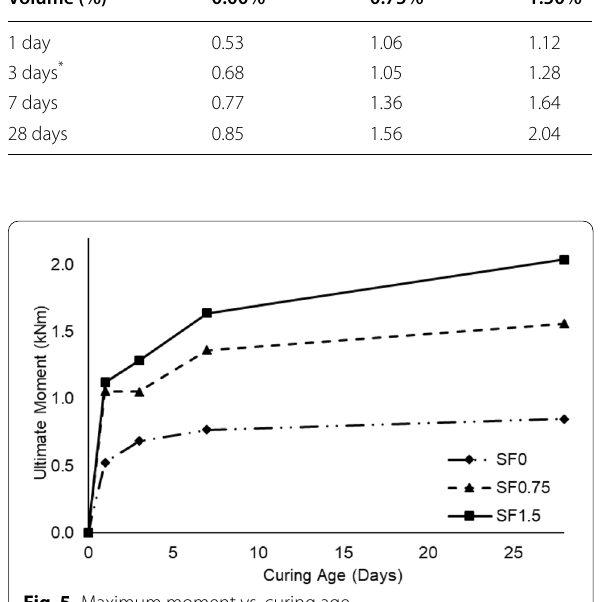
Fig. 3 Compressive strength vs. curing Age